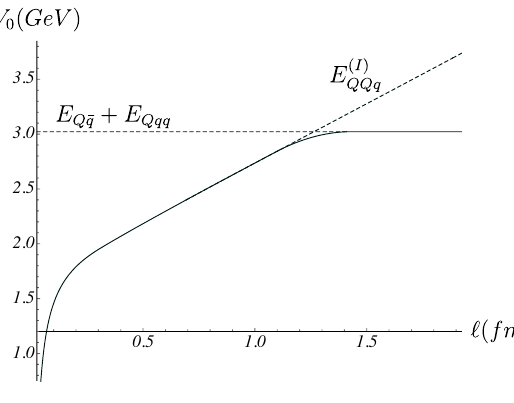
Figure 11 . The potential of the QQq